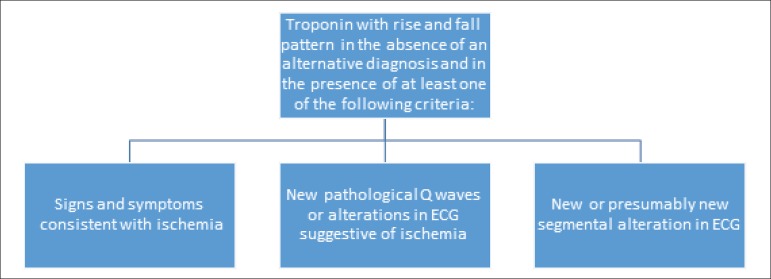
Strategy for the diagnosis of perioperative MI. ECG:
Electrocardiogram.